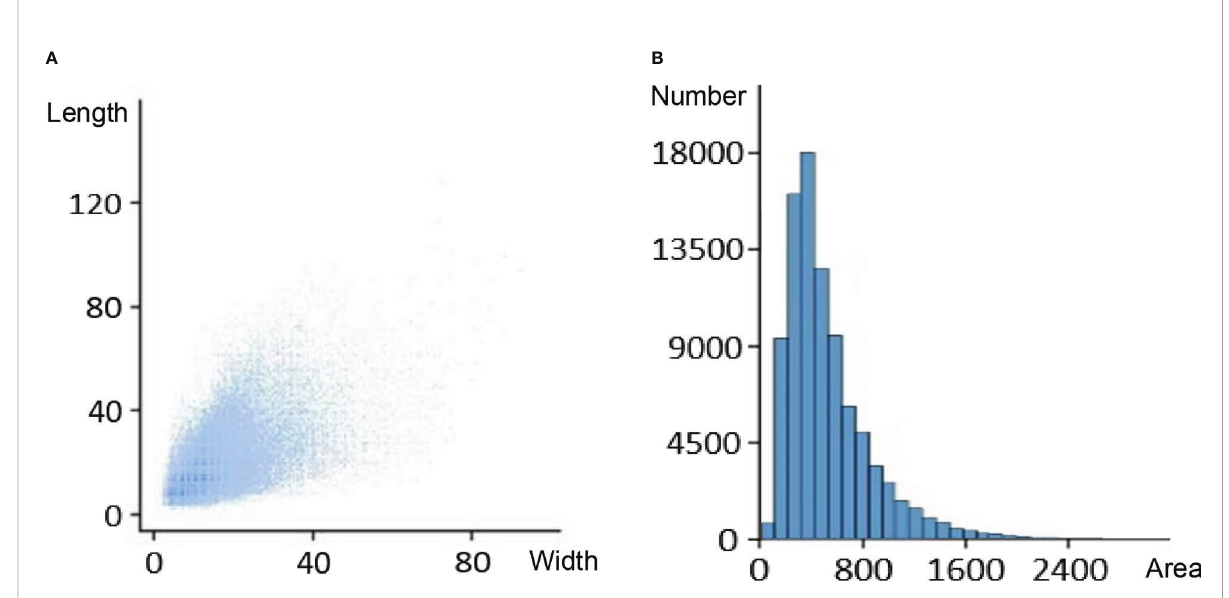
FIGURE 8 Labeled data distribution: (A) size distribution. (B) area